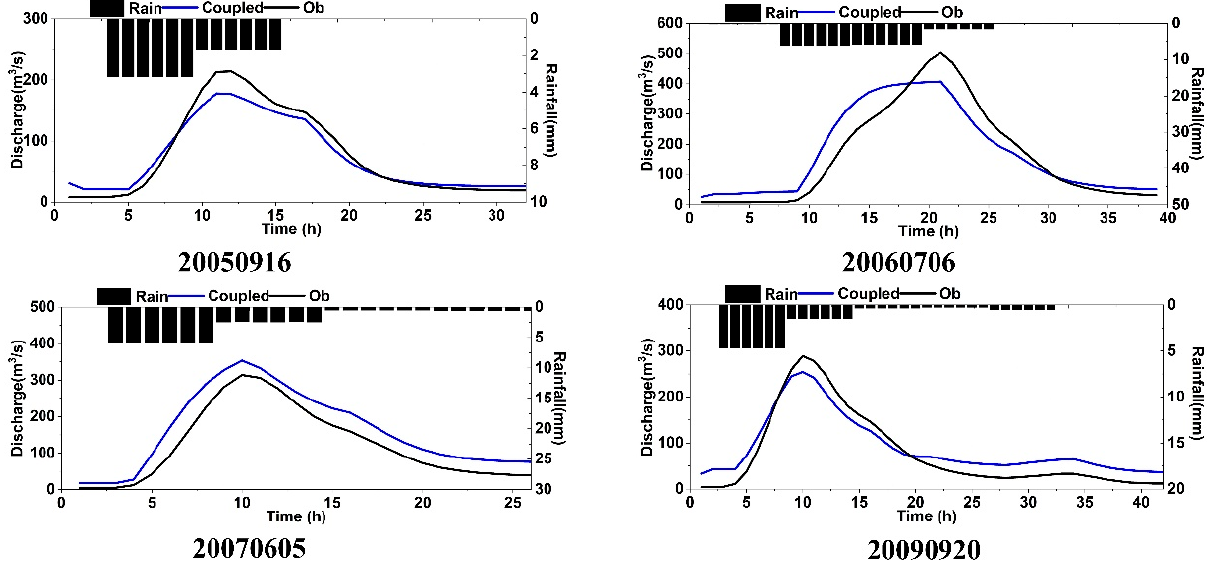
Figure 7. Comparison between the simulated and observed discharge values of the major flood events.